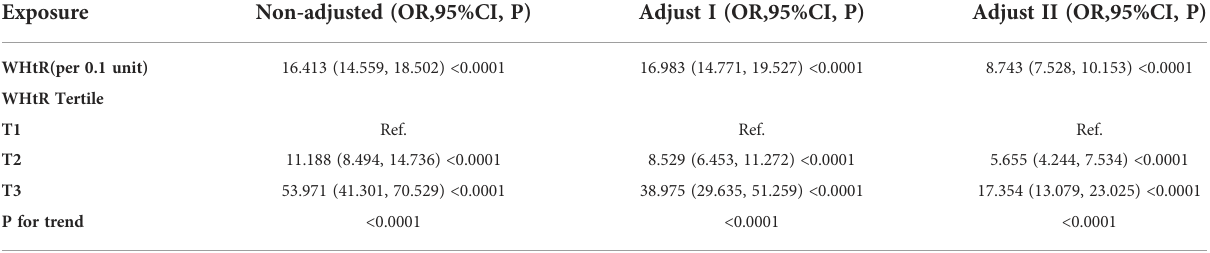
TABLE 6 Relationship between Waist-to-height ratio and NAFLD in different models. Exposure Non-adjusted (OR,95%CI, P) Adjust I (OR,95%CI, P) Adjust II (OR,95%CI, P) WHtR(per 0.1 unit) WHtR Tertile T1